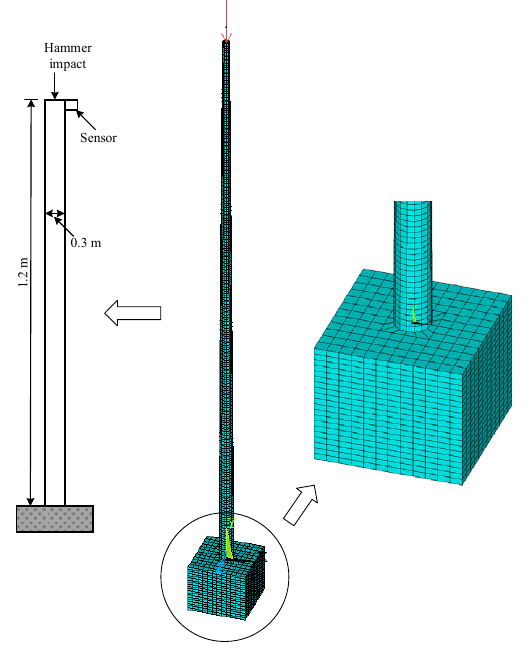
Figure 3. Finite Element (FE) model with the fixed boundary.